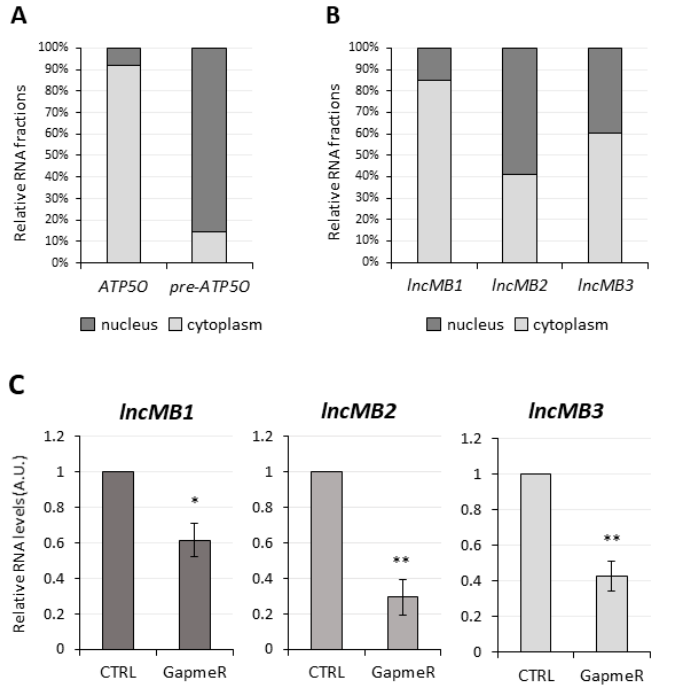
Figure 7. Subcellular localization and knock-down of lncMB1 , lncMB2 and lncMB3 in DOX-untreated D283-OMO cells. ( A ) qRT-PCR analysis of ATP5O and pre-ATP5O transcripts in nuclear (dark grey bars) and cytoplasmic (light grey bars) fractions from DOX-untreated D283-OMO cells. Normalizations were performed on the total amount of RNA. Data are expressed as a percentage of the total levels of ATP5O or pre-ATP5O . N = 1. ( B ) qRT-PCR analyses of lncMB1 , lncMB2 and lncMB3 expression in nuclear (dark grey bars) and cytoplasmic (light grey bars) fractions derived from DOX-untreated D283-OMO cells. Details as in ( A ). ( C ) qRT-PCR analyses of lncMB1 ( left panel), lncMB2 ( middle panel), and lncMB3 ( right panel), expression levels upon specific LNA GapmeR transfections in DOX-untreated D283-OMO cells. Expression was set as 1 in scrambled-transfected control cells (CTRL). Data (means ± SEM) are expressed in arbitrary units (A.U.) and are relative to Atp5o mRNA. N = 4, * p ≤ 0.05, ** p ≤ 0.01 (two-tailed Student’s t